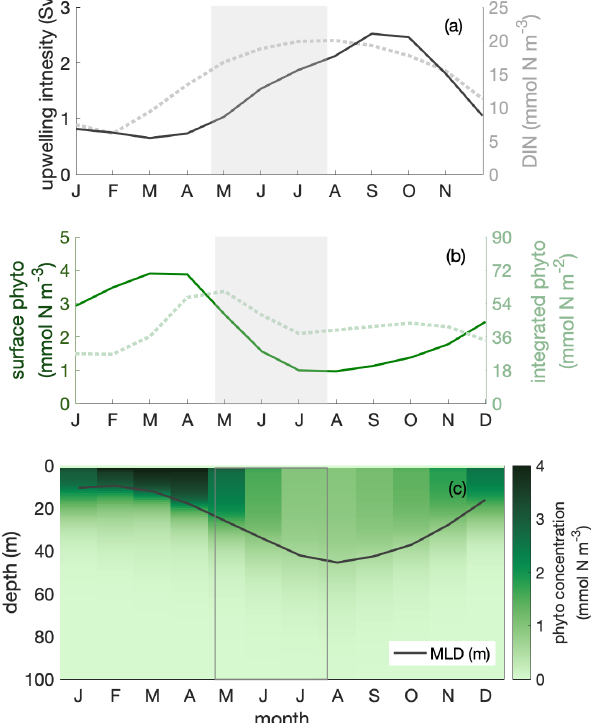
Figure 3. Seasonal cycles of (a) upwelling intensity (in sverdrups; solid line) and surface dissolved inorganic nitrogen (DIN) concen- tration (in mmolNm − 3 ; dotted line); (b) surface (in mmolNm − 3 ; solid line) and mixed layer depth (MLD)-integrated phytoplankton biomass (in mmolNm − 2 ; dotted line); (c) phytoplankton depth– month distribution, showing the seasonal cycle of MLD (in metres; solid line) within the focus region. The shaded area indicates the decline phase of MLD-integrated phytoplankton